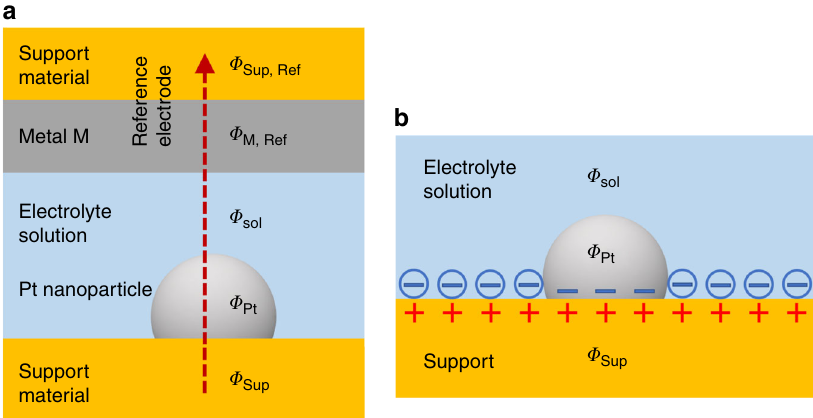
, i.e. for zero charge on the external Pt Pt ¼ 0